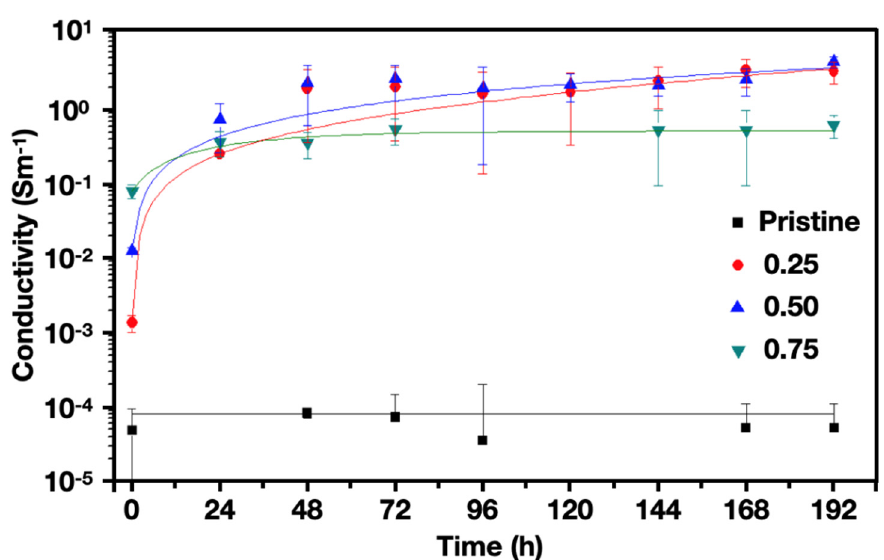
Figure 5. Electrical conductivity of 4 different epoxy samples with different concentrations of carbon nanotubes (CNTs) (0, 0.25, 0.5 and 0.75 wt. %) immersed in artificial sea water at 80 °C. Data were recorded every 24 h.